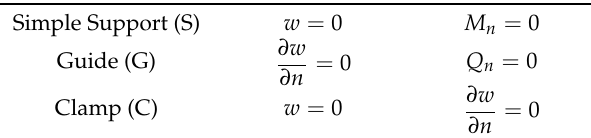
Table 1. Boundary conditions of a rectangular